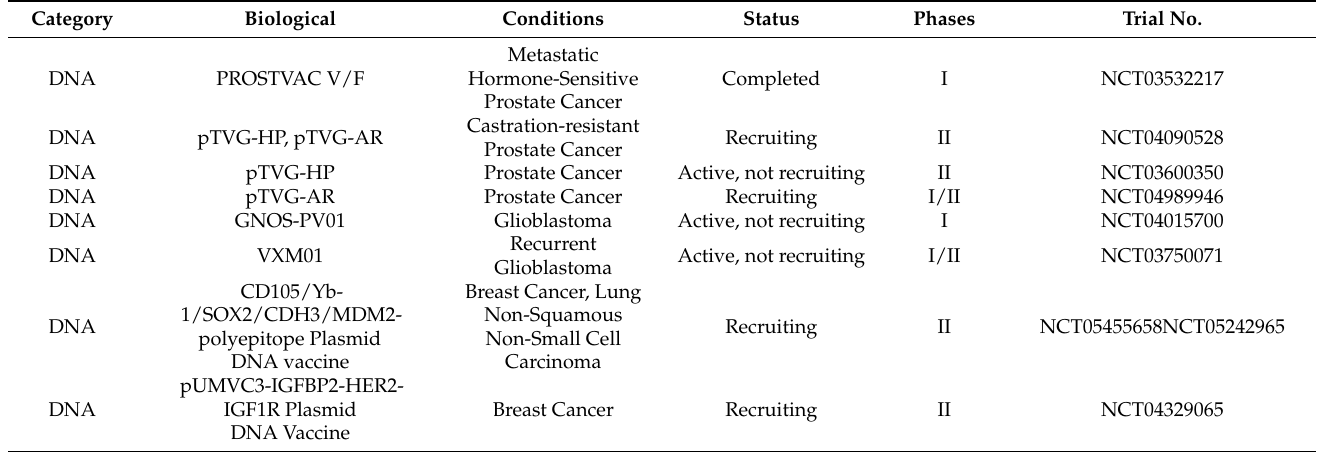
Table 2. DNA-based cancer vaccines in clinical